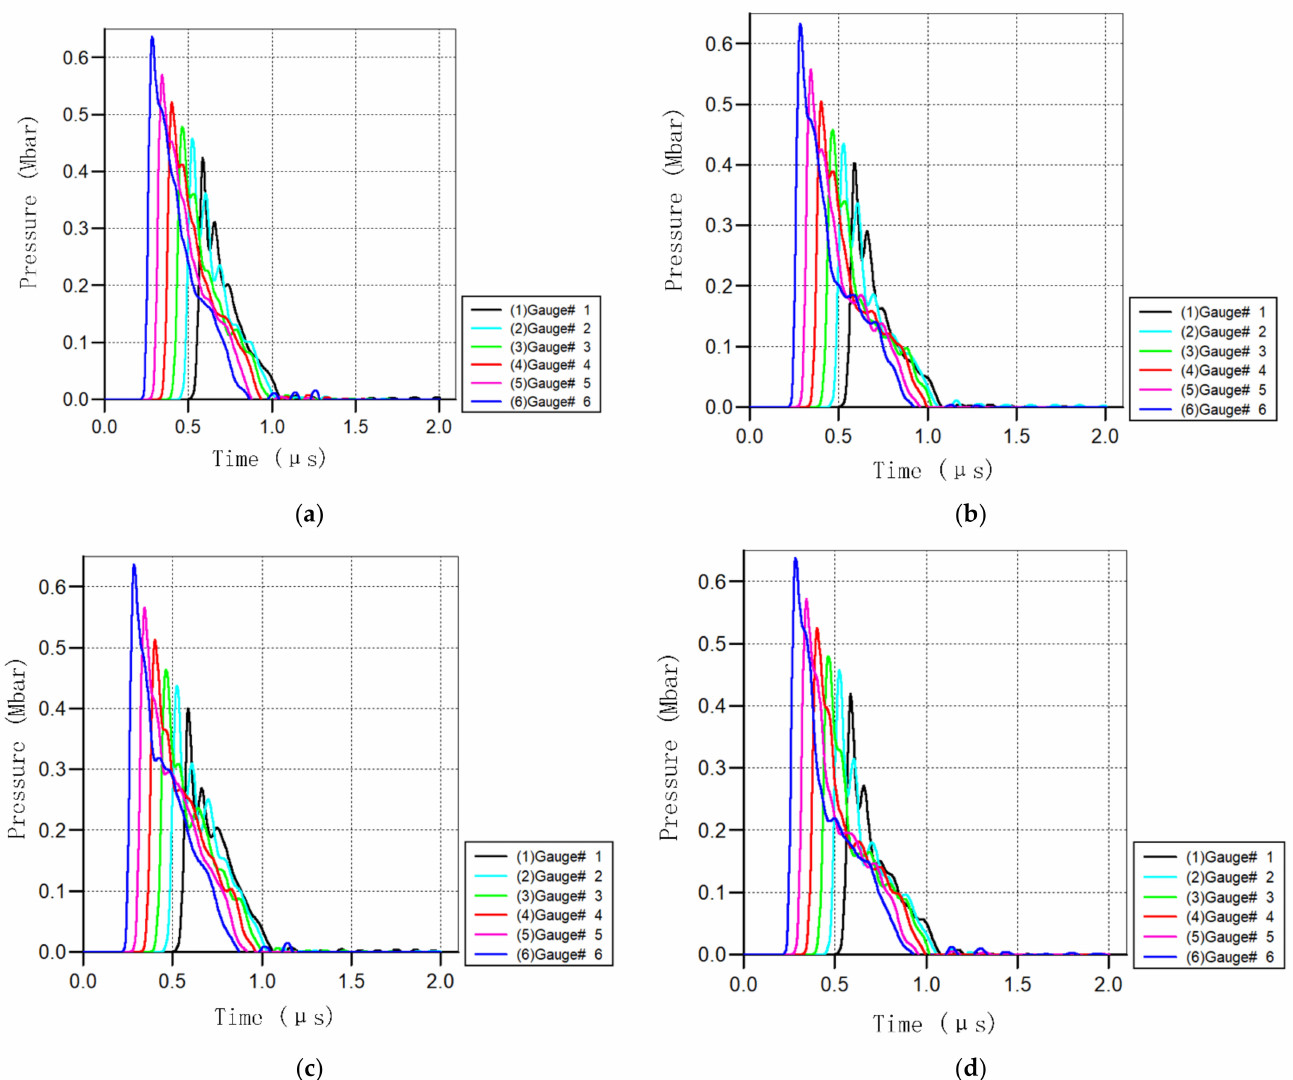
Figure 5. Shock-wave amplitudes at different positions in the projectile: ( a ) Ti-Al-Mg-Ny protective screen; ( b ) Ti-Al-Ny protective screen; ( c ) Ti-Mg-Ny protective screen; ( d ) Ti-Ny protective